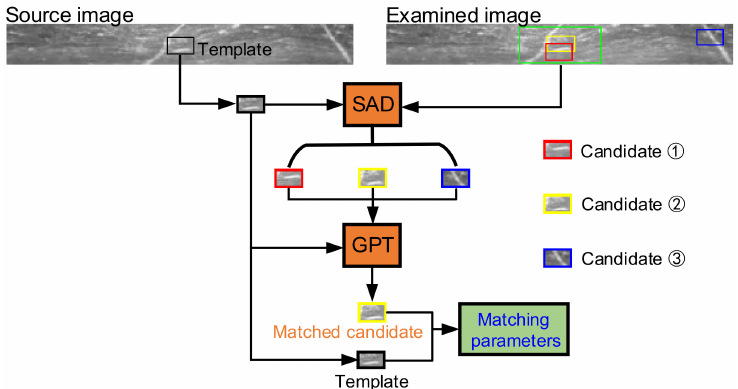
Figure 10. The architecture of the proposed projection transformation sum of the absolute di ff erence (PTSAD)